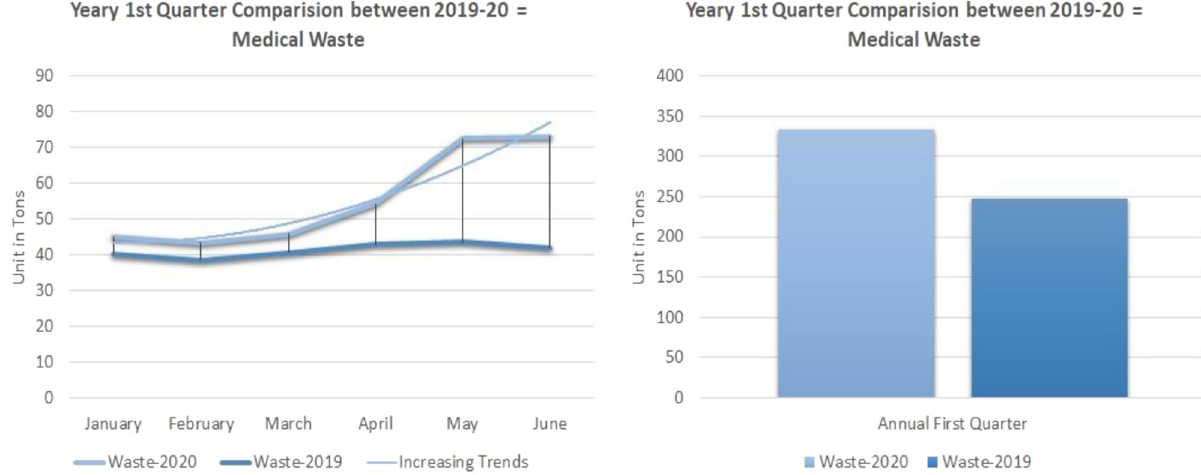
Fig. 8. Trend for the medical waste for the 1st quarter (2019 – 2020) (Ajman (cid:1) UAE)